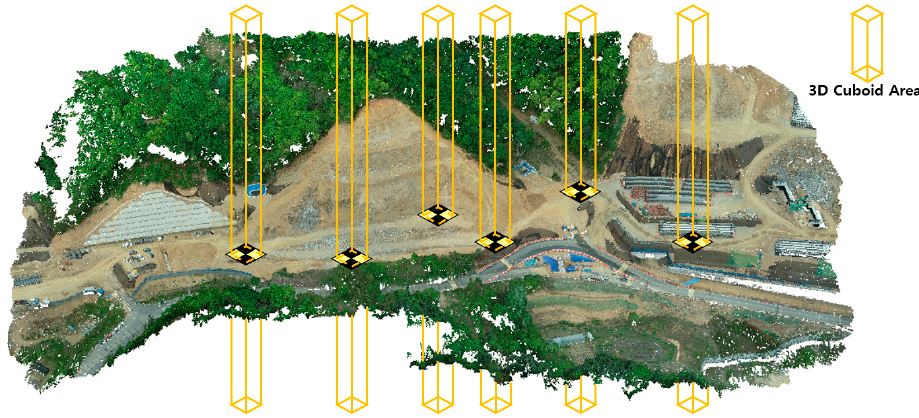
Figure 3. An idea for extracting Z-coordinates of GCPs from point cloud data.